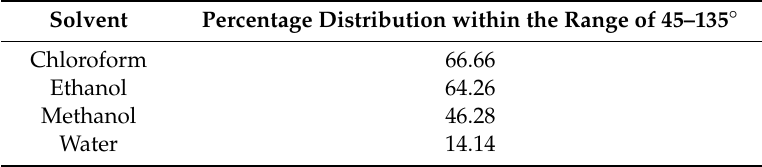
Table 5. Results of paracetamol simulations in di ff erent